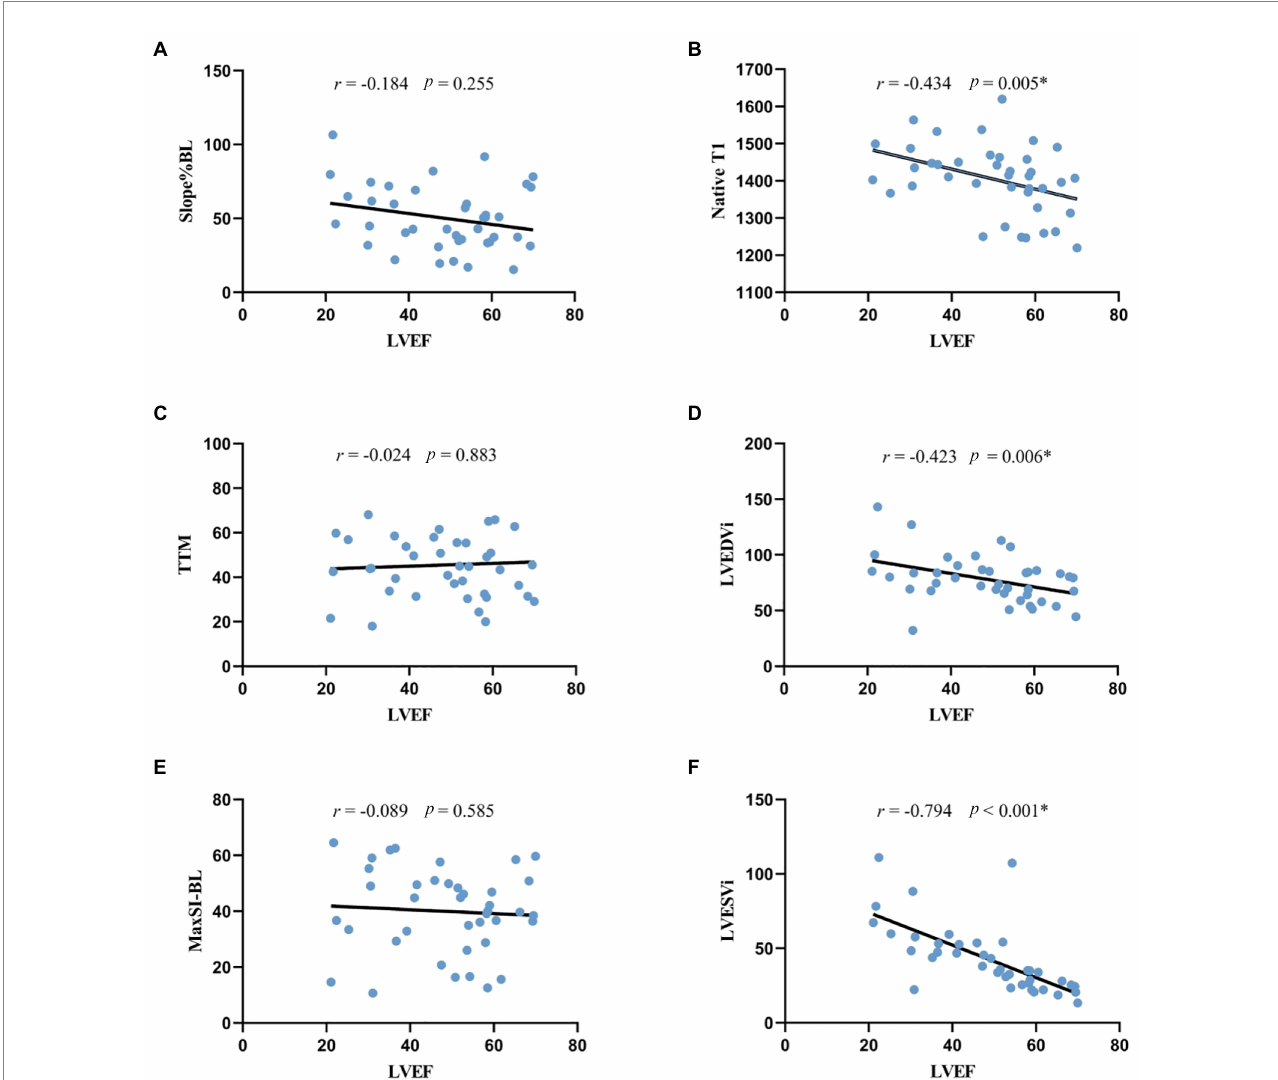
FIGURE 4 Correlation analysis between LVEF and morphologic, perfusion and quantitative mapping parameters. * p < 0.05. (A,C,E) the correlation between LVEF and rest first-pass perfusion parameters, indicating the negative correlation was not statistically significant. (B) the negative correlation between LVEF and native T1 was statistically significant. (D,F) LVEF was significantly correlated with LV morphologic parameters. LVEF, left ventricular ejection fraction; Slope%BL, slope dividing baseline signal intensity; TTM, time to maximal signal intensity; MaxSI-BL, maximal signal intensity subtracting baseline signal intensity; LVEDVi, left ventricular end-diastolic volume index; LVESVi, left ventricular end-systolic volume